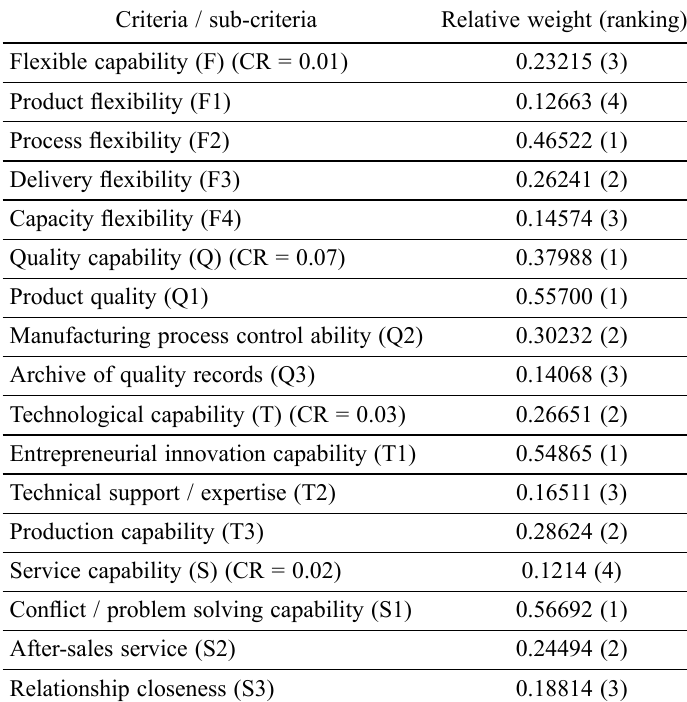
Table 8. Relative weights of criteria / sub-criteria Criteria /